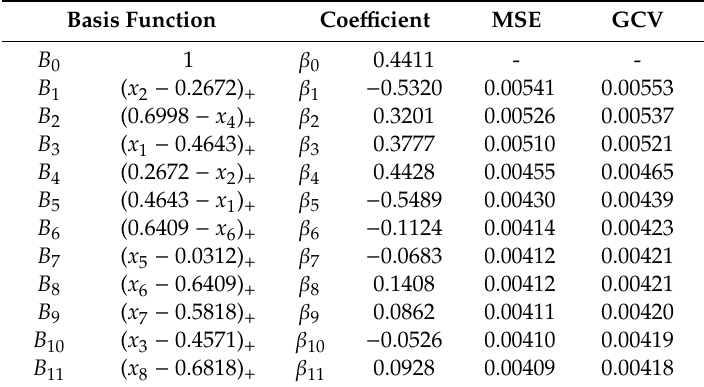
Table 3. Model equations for MARS { S = 1, I = 1, M F = 21, d = 2, L = 4, w = 2000} at t = 11,755. The mean squared error (MSE) and the generalized cross validation (GCV) of the model predictions for the training data are 0.00408 and 0.00418, respectively. The columns MSE and GCV indicate the new values obtained when the basis function is removed from the